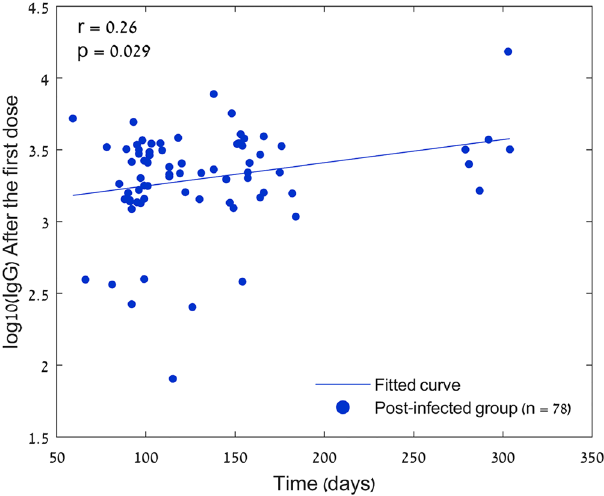
Figure 3. Scatterplot of the time from infection to first vaccination in days, and IgG-S responses in the post- infected cohort. r is Pearson’s correlation